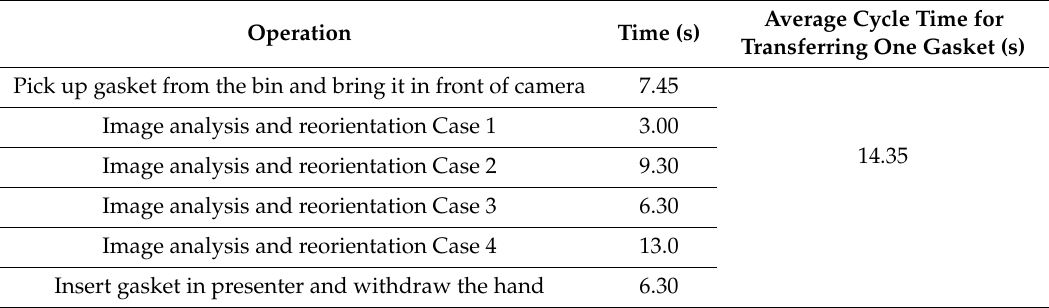
Table 1. Duration of each operation and average cycle time for transferring one fuel cell component. The last step did not add additional time since it was performed simultaneously with the first step.